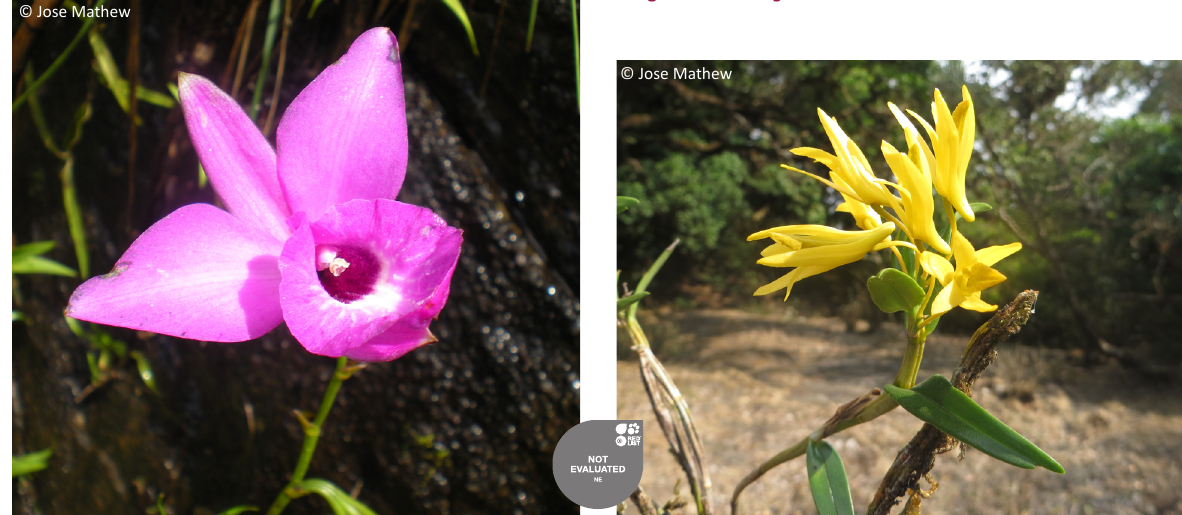
Image 8. Vanilla wightiana Lindl. ex Hook.f.